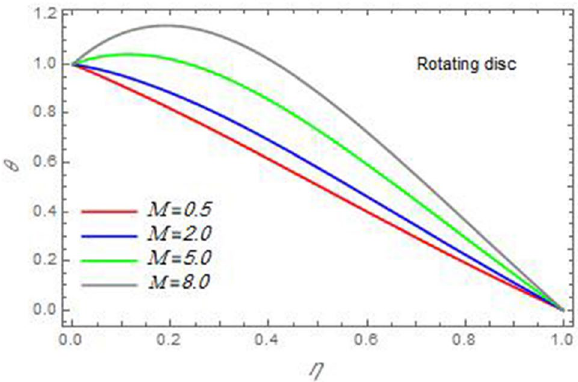
Figure 20. The temperature distribution θ is plotted versus the axial variable η in the case of stationary cone to depict the effect of the magnetic parameter M .